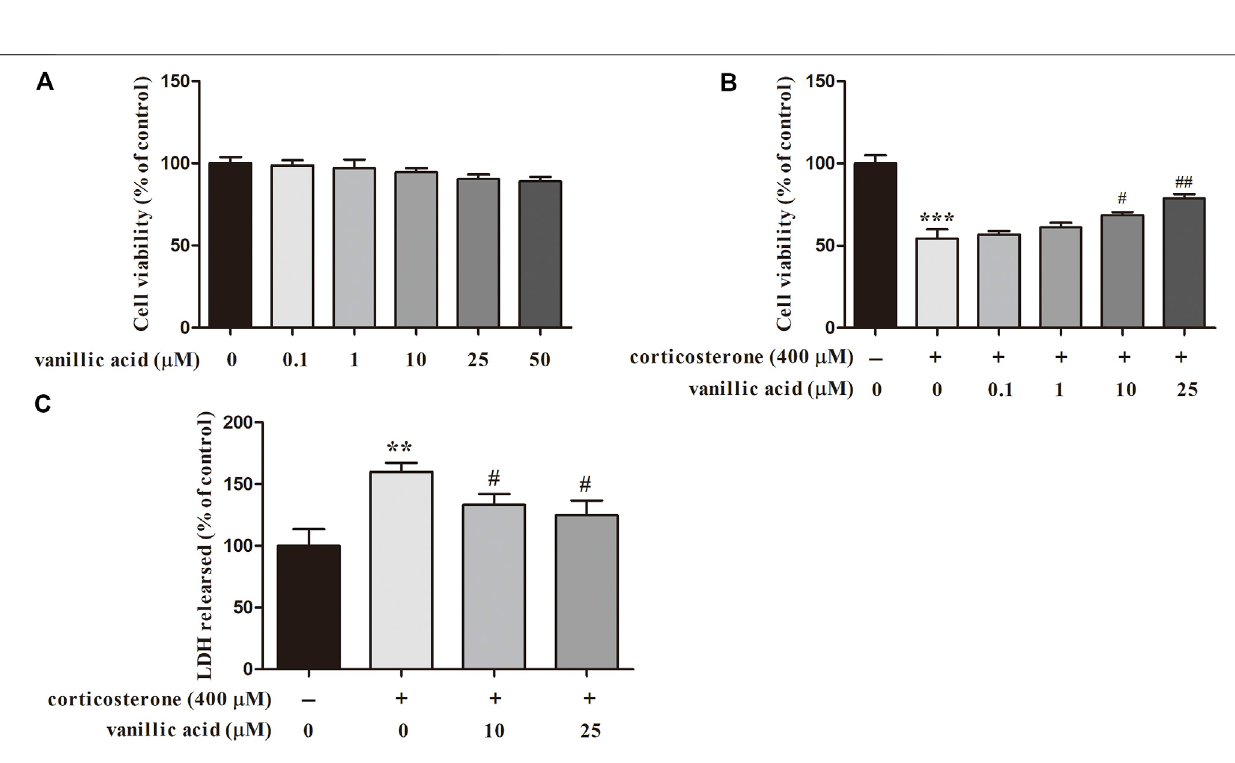
Frontiers in Pharmacology |